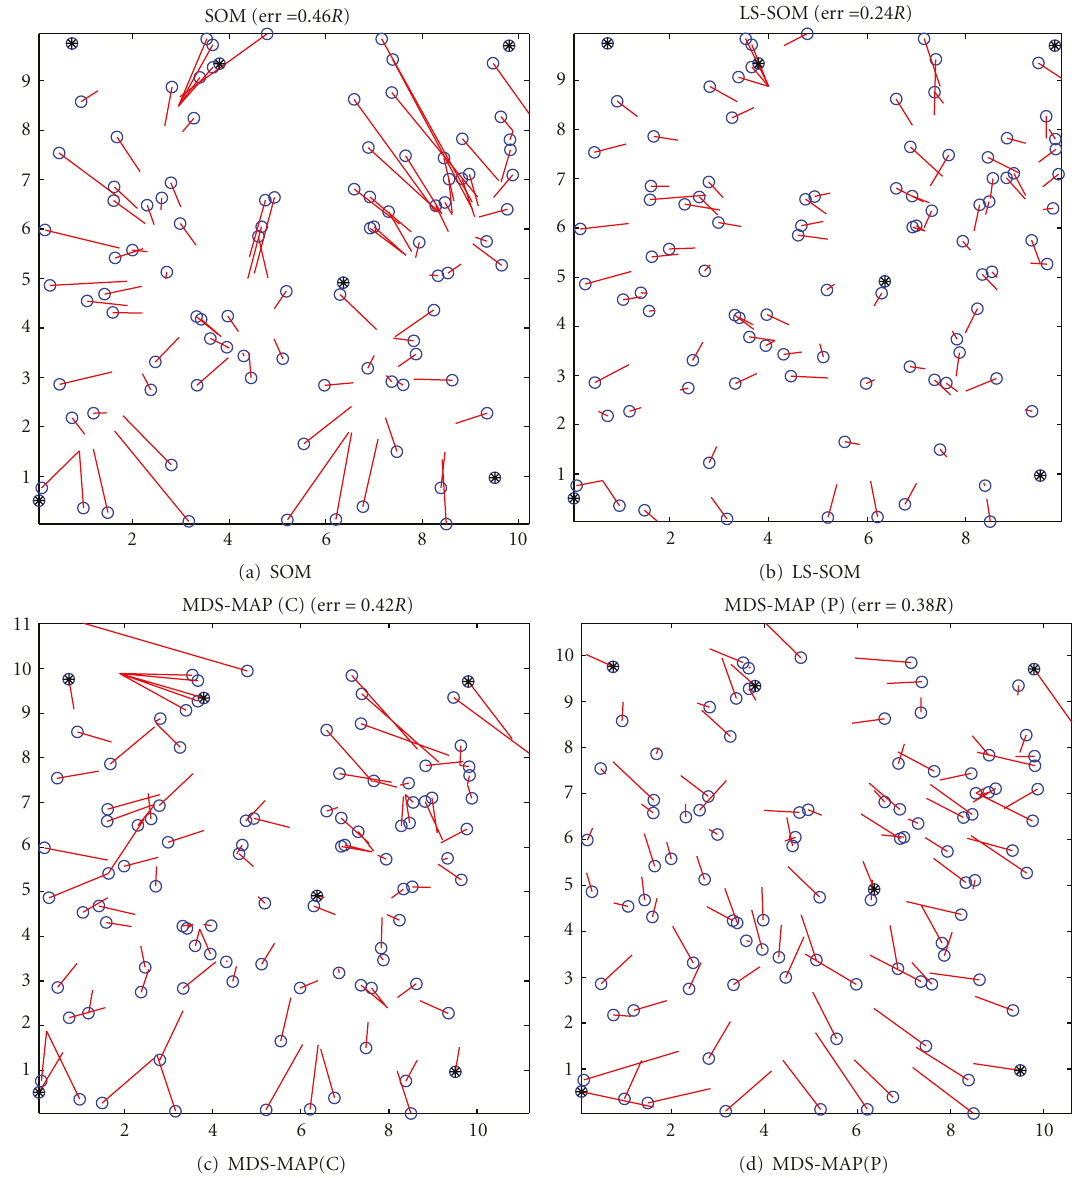
Figure 10: Estimation for random deployment